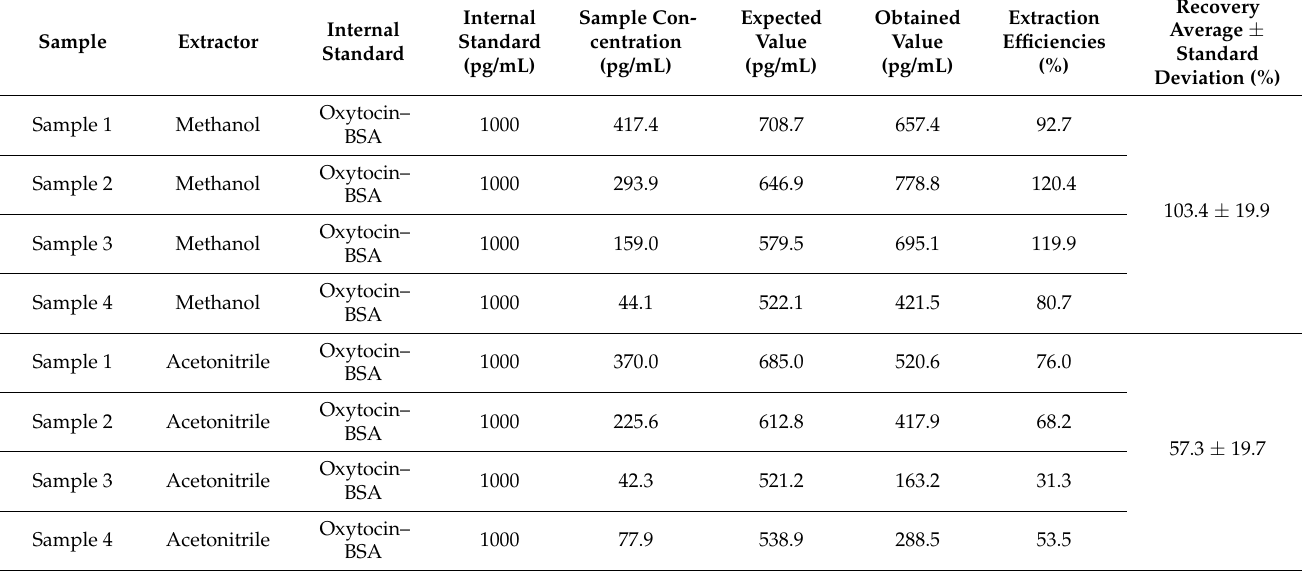
Table 1. Oxytocin concentrations in the hair pool samples (1–4), concentrations of the internal standard, extraction efficiencies, and recovery averages (mean of the four ± each standard variation) of the extraction procedures with methanol and